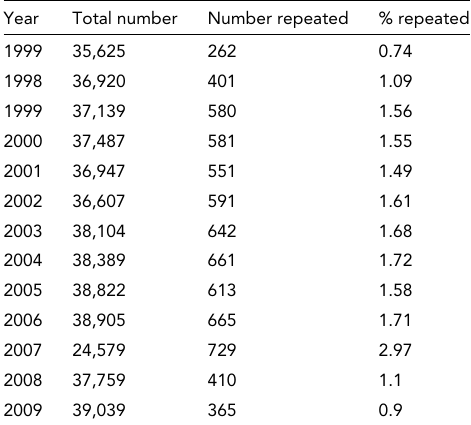
Total Numbers, Numbers Repeated and Percentage of Students Aged 5 Years Repeated in Queensland State Schools 1997–2009 (DET,